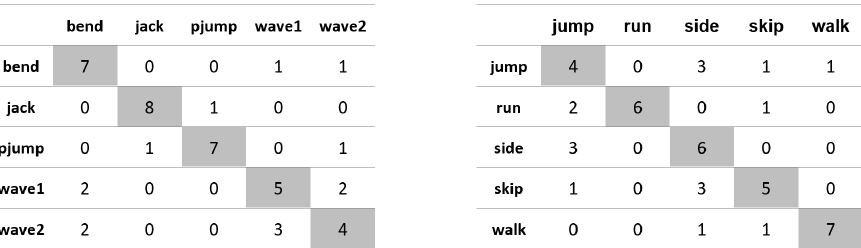
Figure A5. Confusion matrices for the experiment using the ‘lower-occlusion’ database, MBR length and Euclidean distance.